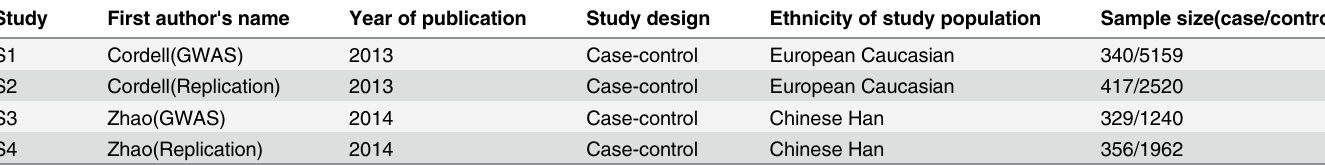
Table 4. The basic information of the studies included in our meta-analysis.